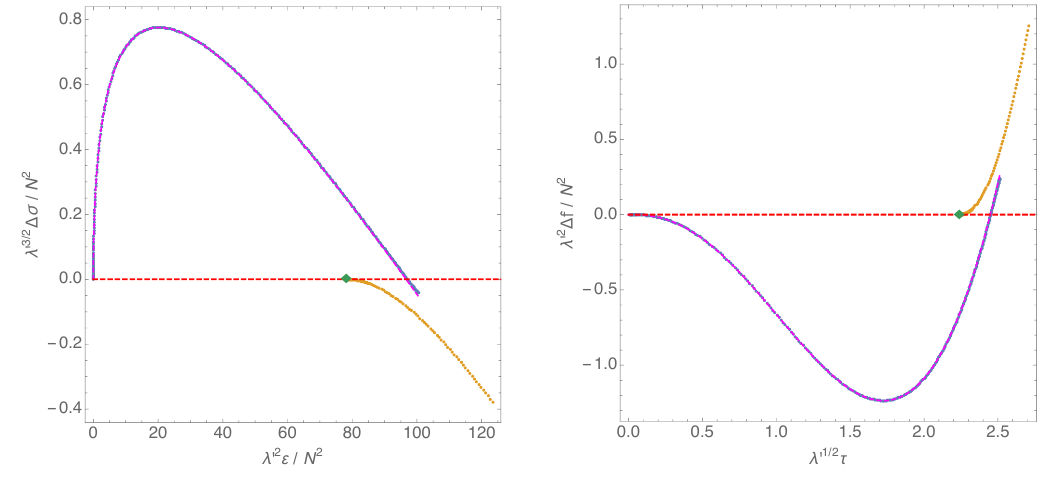
Figure 4 . Left panel: phase diagram of thermal phases of SYM on a circle S 1 in the micro- (1+1) canonical ensemble. (cid:1) (cid:27) gives the entropy di(cid:11)erence between a given thermal phase and the uniform phase with the same energy " . Right panel: phase diagram of thermal phases of (1+1)-dimensional SYM on a circle S 1 in the canonical ensemble. (cid:1) f gives the free energy di(cid:11)erence between a given thermal phase and the uniform phase with the same energy " . In these diagrams the horizontal (dashed red) line describes the uniform thermal phase. The orange points represents the nonuniform thermal family and the blue points describes the localised thermal phase. The magenta dashed line represents the perturbative results for localised black